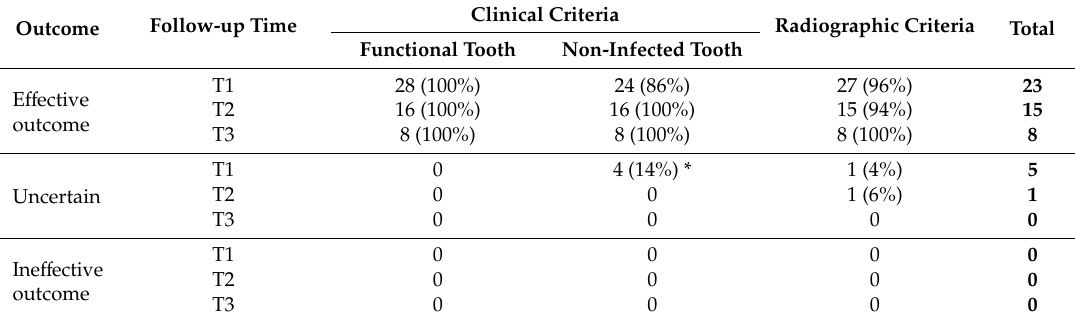
Table 4. Distribution of teeth according to the outcome of the combined treatment (full pulpotomy and immediate coverage with endocrown) at di ff erent follow-up times: T1 (1 month), T2 (6 months) or T3 (12